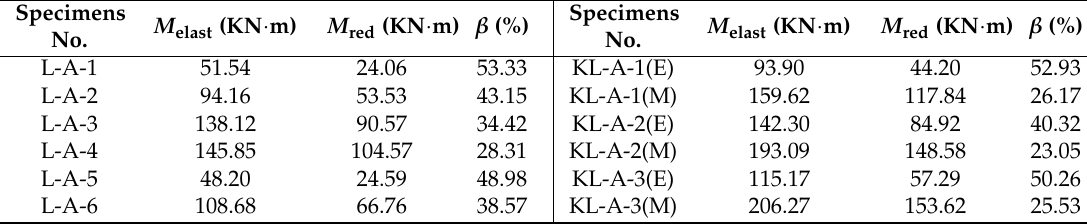
Figure 6. Evolution of moment redistribution for L-A-2 and KL-B-4. Figure 5. Comparison of the elastic and test reactions for L-A-2. Table 4. Moment redistribution for test